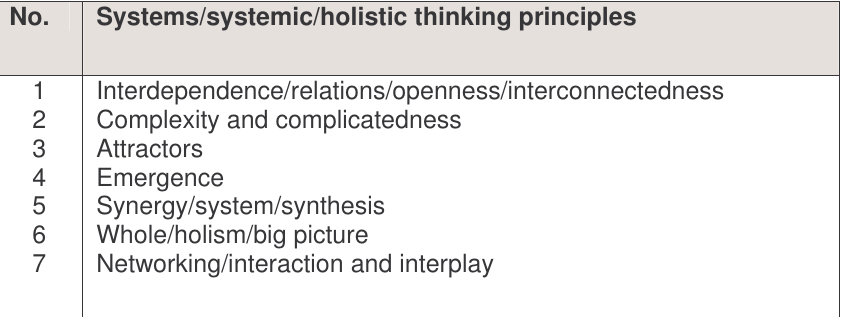
Table 2: Seven groups of systems thinking principles